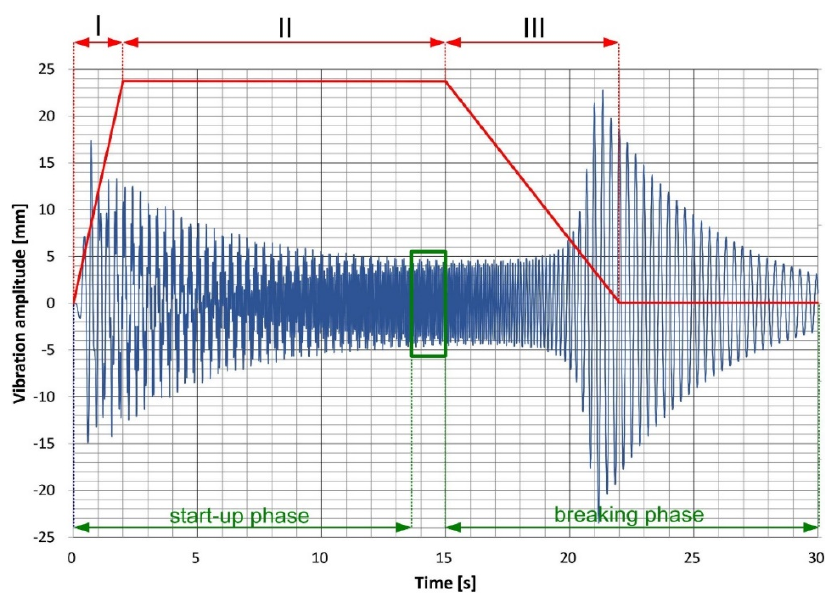
Figure 3. Vibration amplitude of the vibrating screen with circular vibrations during start-up and braking versus time.